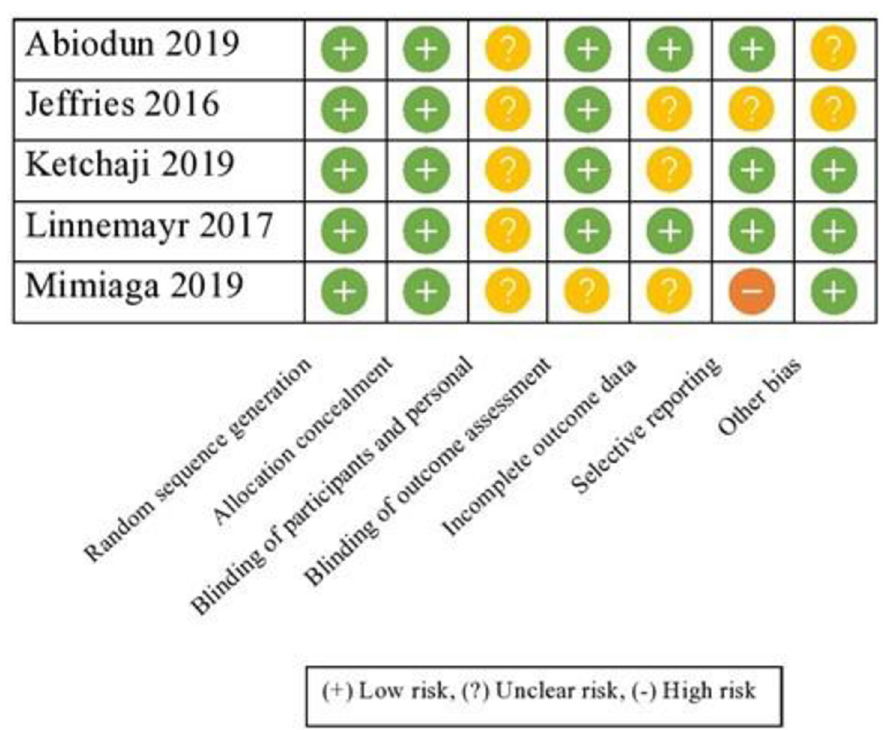
Fig 2. Quality assessment of included studies that were